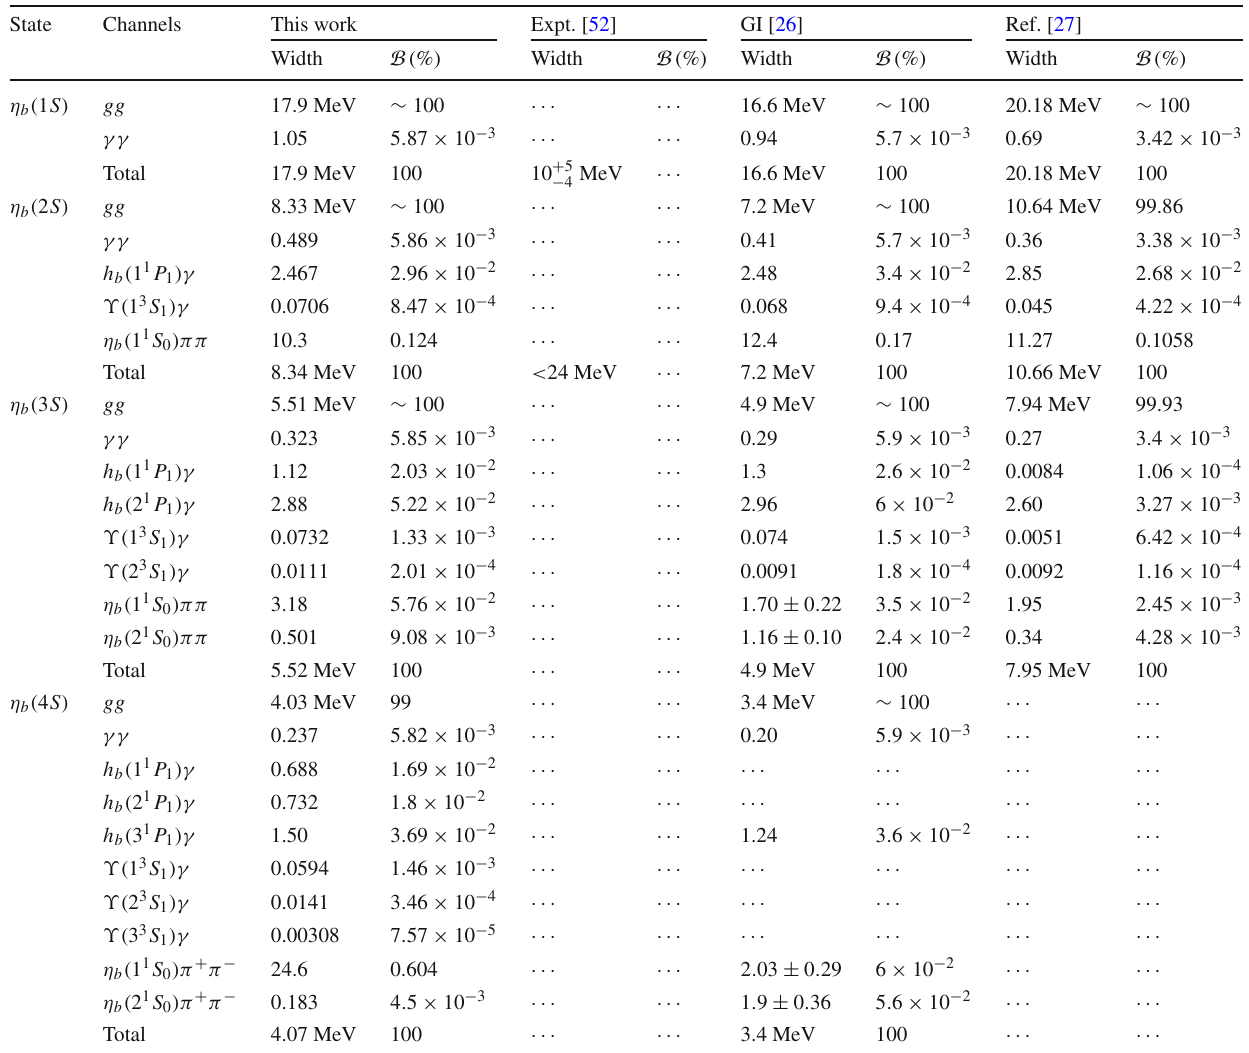
Table 4 Partial widths and branching ratios of annihilation decay, radiative transition, and hadronic transition and total widths for the S -wave η b below the open-bottom thresholds. Experimental results are taken from the PDG [52]. The theoretical results of the Godfrey–Isgur